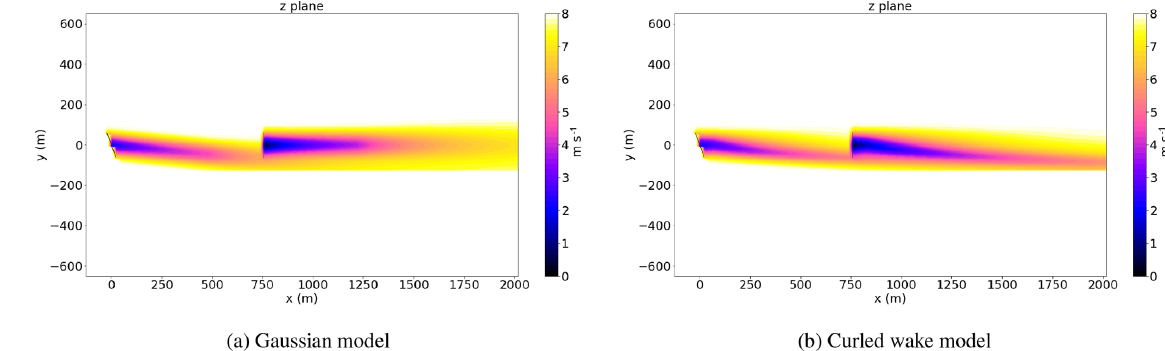
Figure 10. FLORIS simulation of two aligned wind turbines yawing the first turbine 25 ◦ .